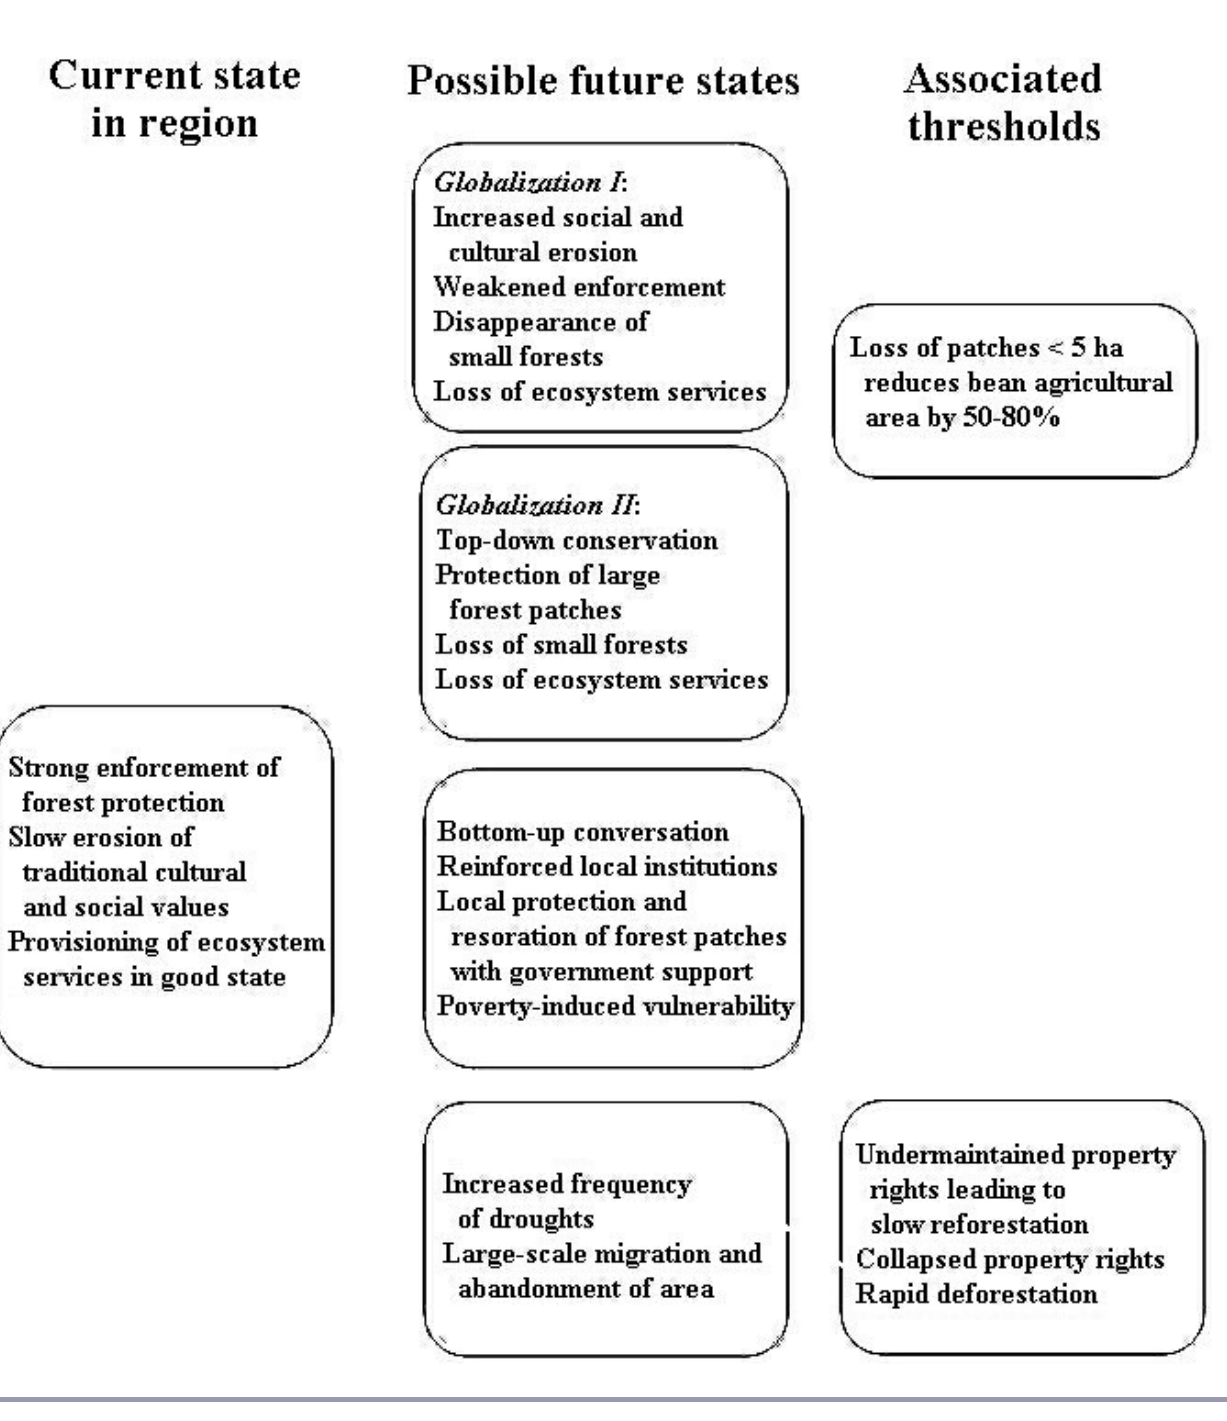
Fig. 9 . The current and possible future states in the Madagascar dry forest region and some of the key